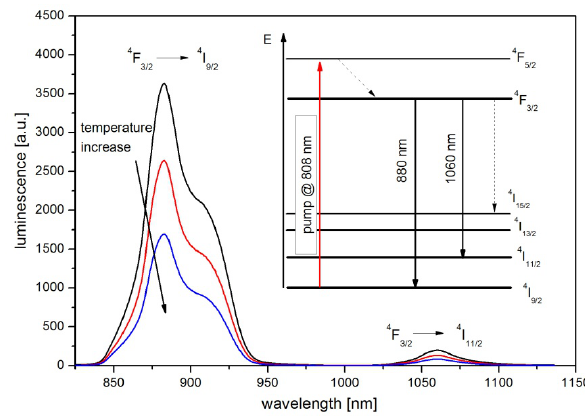
Figure 2: Luminescence spectra of Nd 3+ -doped fibre against temper- ature.